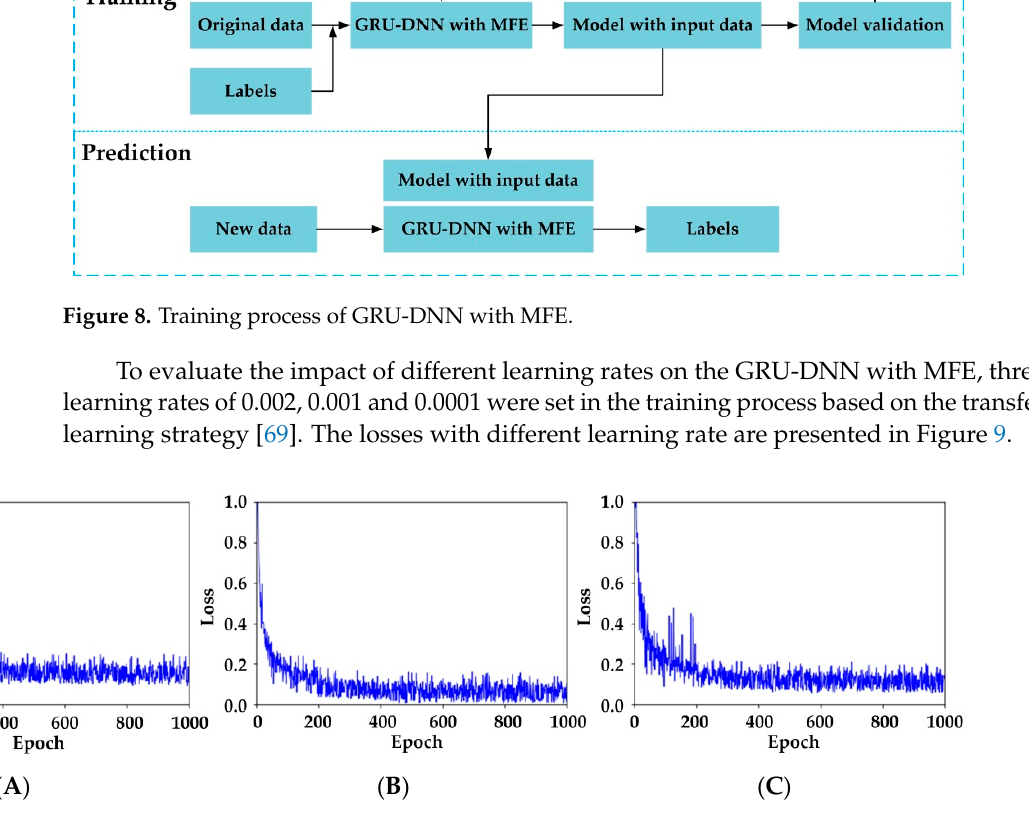
Table 5. Performance of DRU-DNN with MFE.